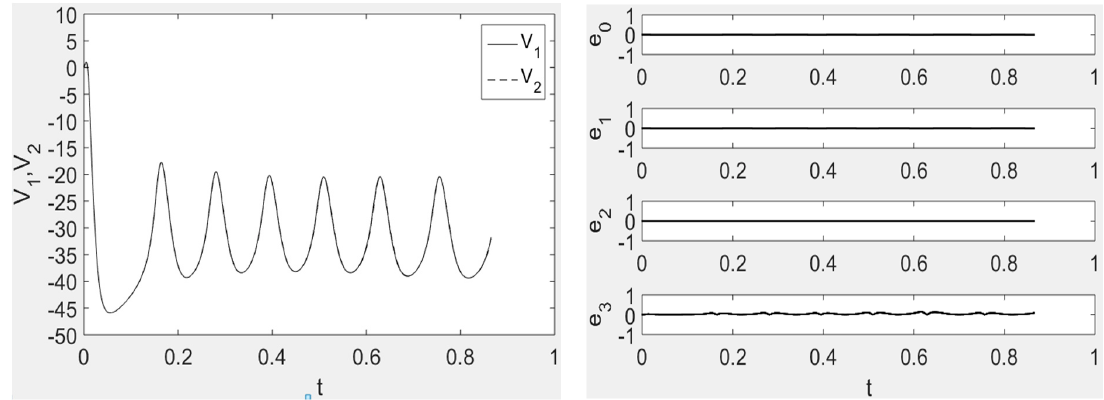
Figure 7. Time histogram and synchronization discrepancy graph when H syn = 1.55 and τ = 0.